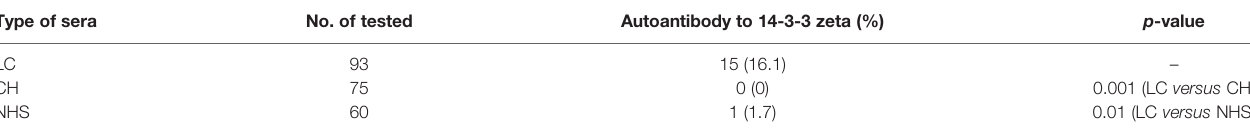
TABLE 2 | Frequency of autoantibody against 14-3-3 zeta in human sera based on ELISA. Type of